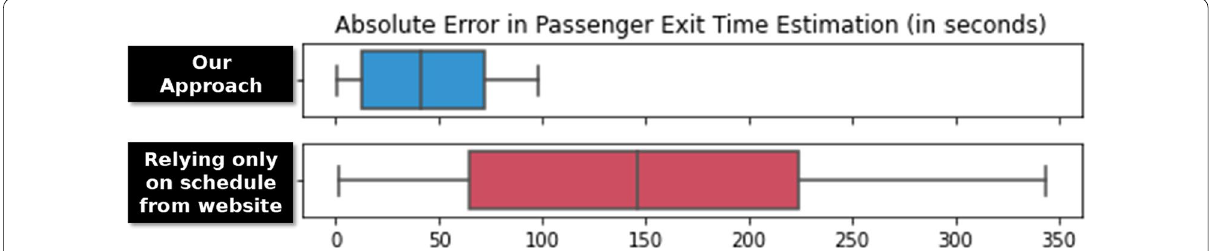
Fig. 15 Absolute error in exit time estimation for passengers in São Sebastião → Reboleira from 10 a.m. to 2 p.m., using our approach and relying only on the operational schedule specifications, showing that our approach can estimate passenger exit times with significantly lower error ( p = 0.0075 )